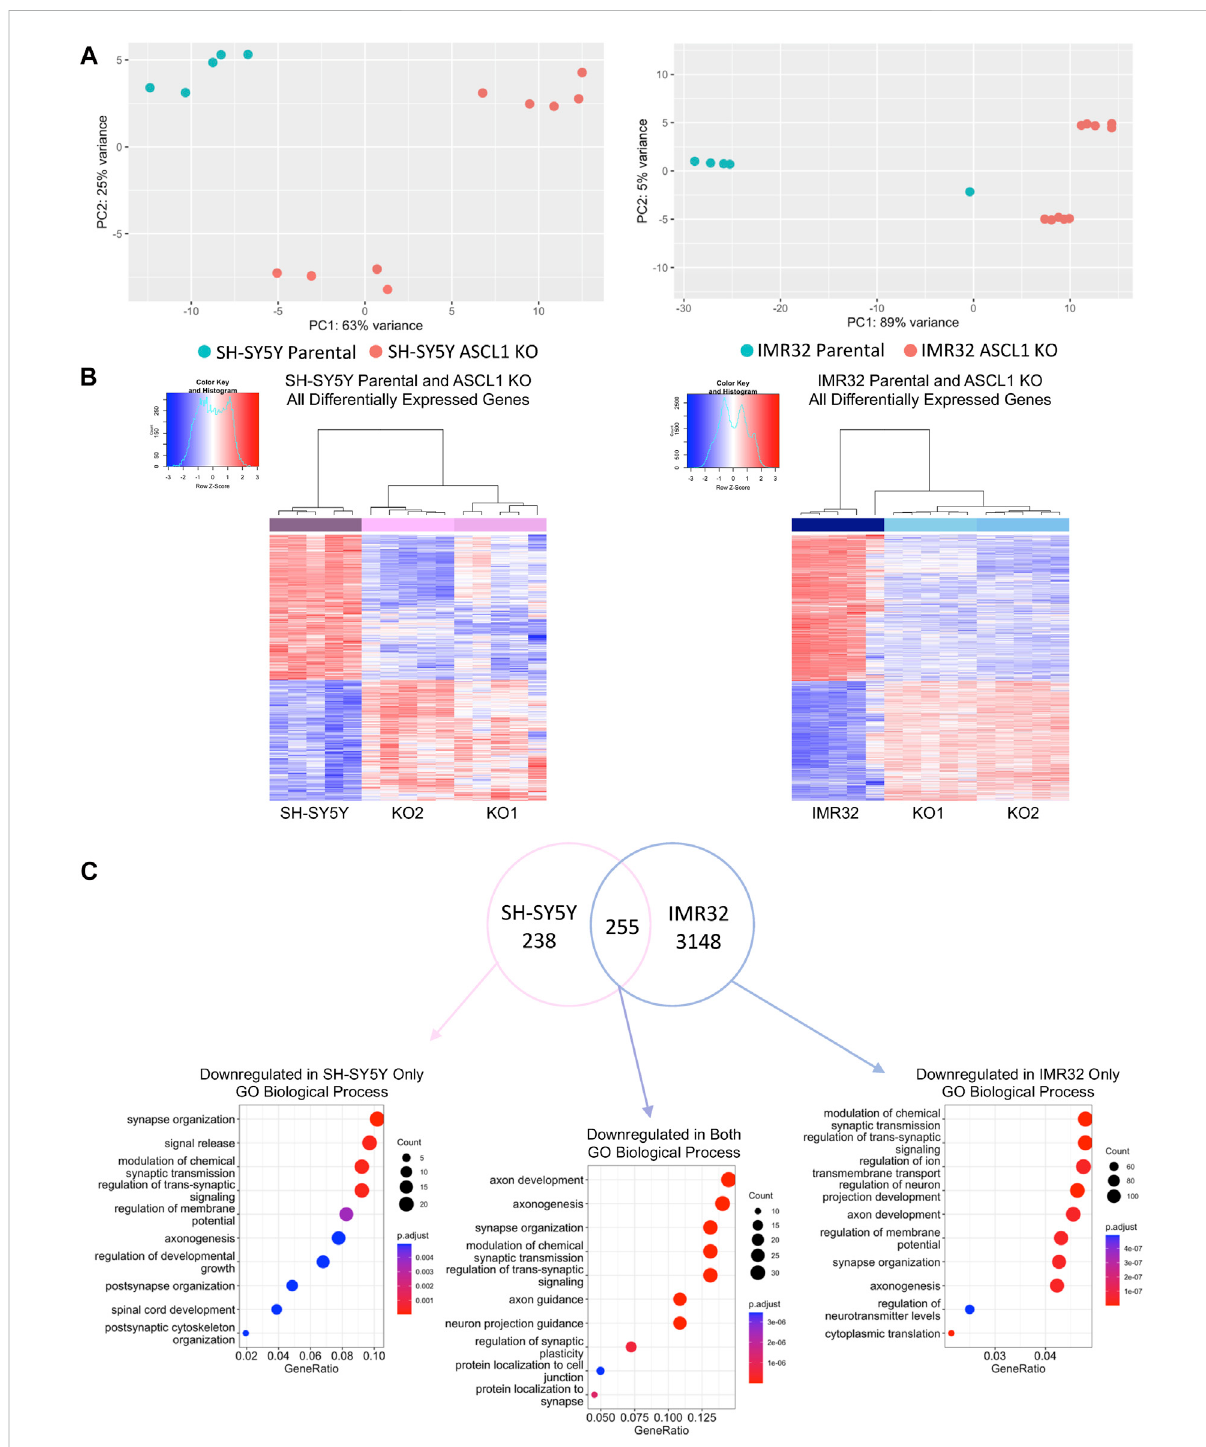
FIGURE 2 ASCL1 knockout results in downregulation of differentiation target genes. (A) PCA plot to show the differences between SH-SY5Y parental and ASCL1 KO lines (left) and IMR32 parental and ASCL1 KO lines (right). (B) Heatmaps to show differentially expressed genes following ASCL1 KO in SH- SY5Y and IMR32 cell lines. (C) Venn diagram to show the genes downregulated in SH-SY5Y ASCL1 KO lines, IMR32 ASCL1 KO lines and the genes downregulated in both (FDR < 0.05, LogFC < -0.25). Gene Ontology analysis was completed on each gene set. The top 10 GO terms associated with biological process are shown. RNA-Seq was completed on 5 biological